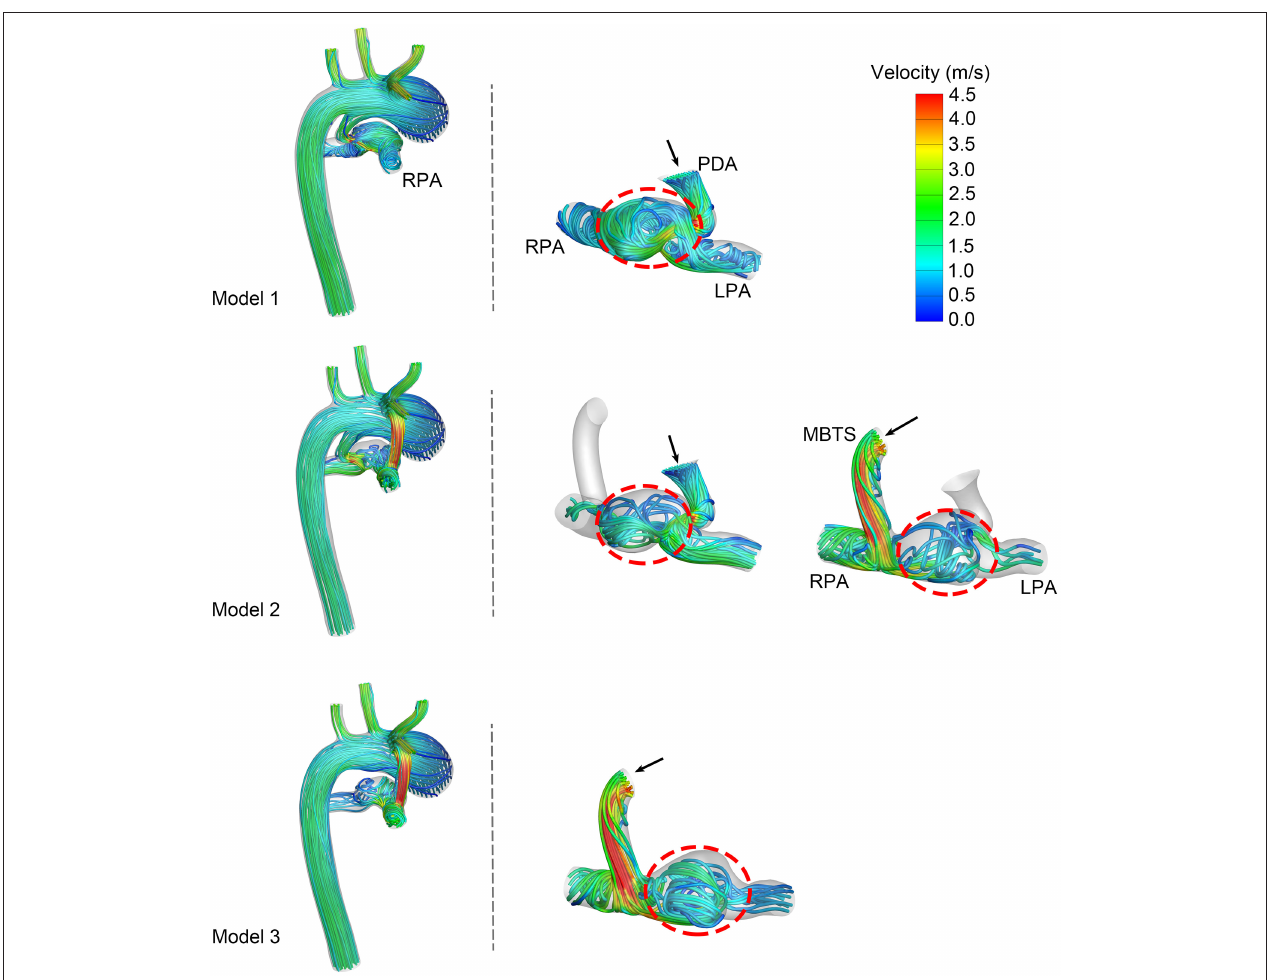
FIGURE 3 | Velocity streamlines at the systolic peak. The left column exhibits the velocity streamlines of the whole model. Another two columns present the streamlines through the patent ductus arteriosus (PDA) and modified Blalock-Taussig shunt (MBTS). The black arrows express the direction of flow, and turbulence is circled in a red dashed line. LPA, left pulmonary artery; RPA, right pulmonary